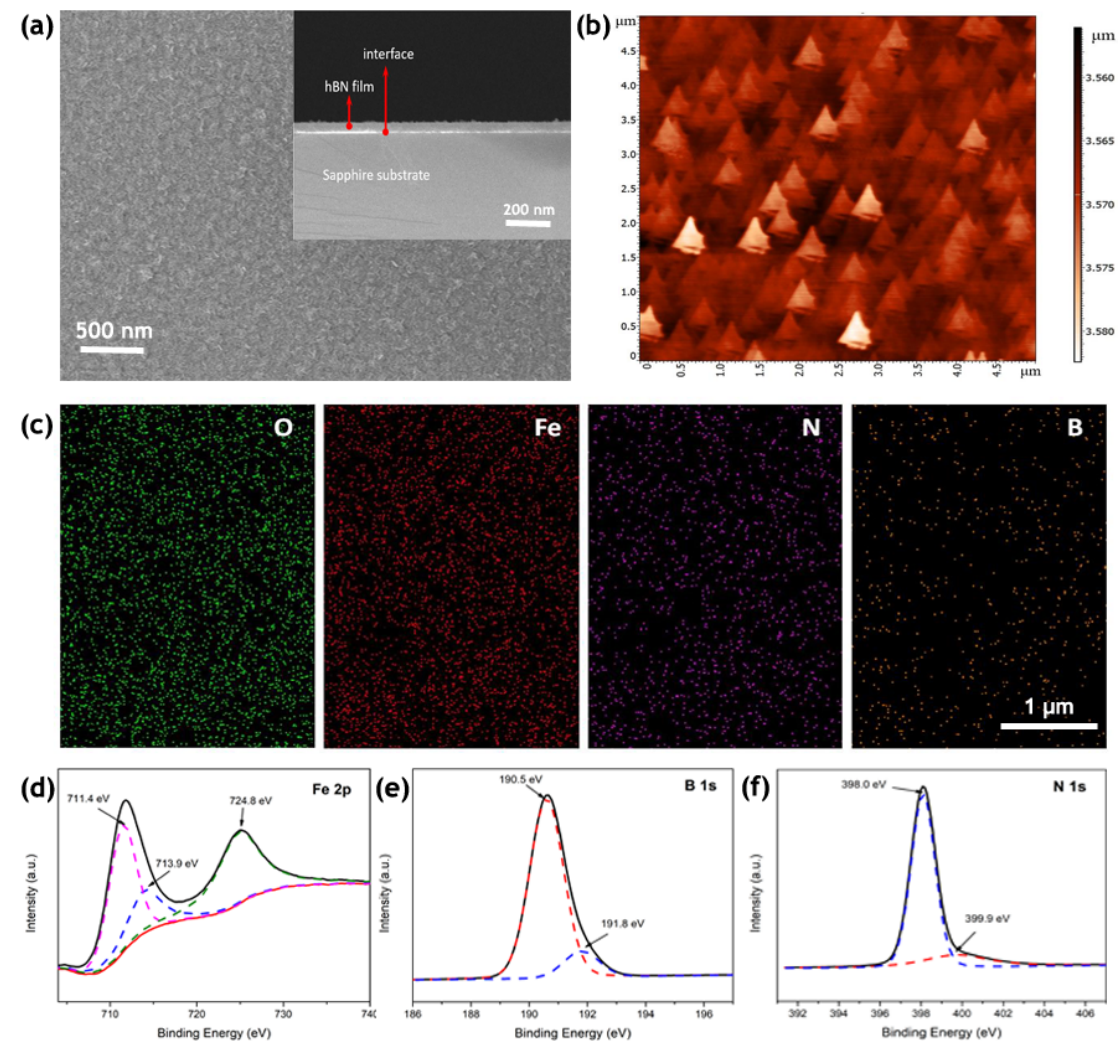
Figure 1. ( a ) The top view and the cross − sectional SEM images of Fe − doped hBN film. ( b ) The AFM image of Fe − doped hBN film (5 μ m × 5 μ m). ( c ) The distribution of element content from EDS. ( d ) The XPS spectra of Fe 2p, (e) B 1s, and (f) N 1s.